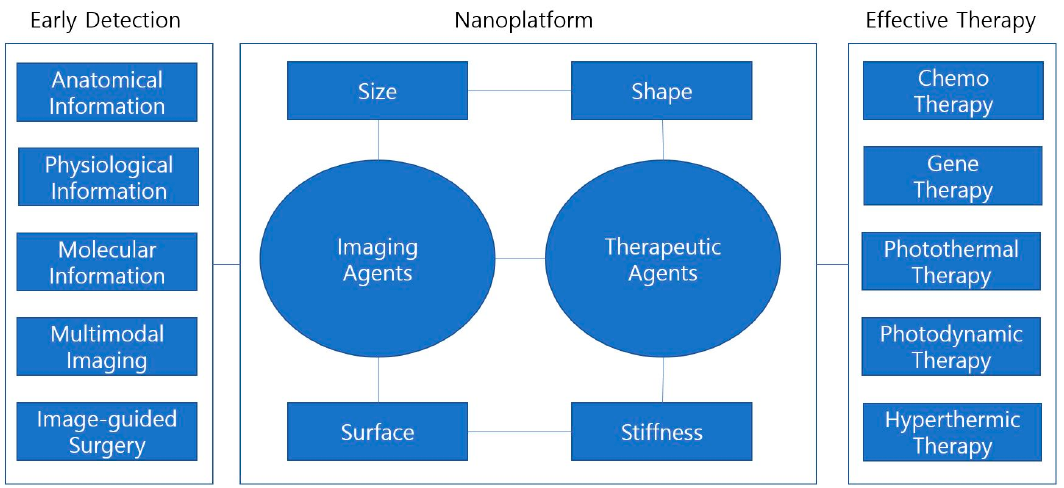
Figure 1. Multicomponent nanoparticles engineered for tumor homing effects.